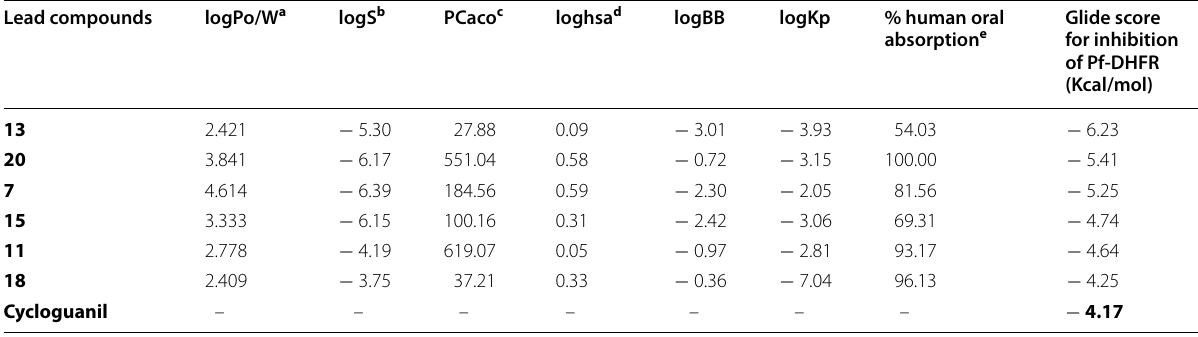
a logPo/w ( b logS (